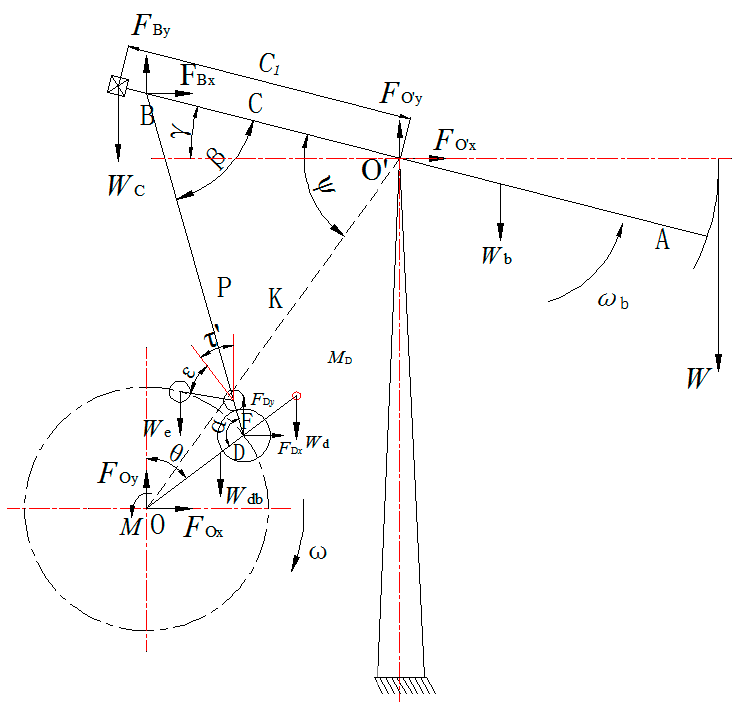
Figure 6. Force analysis diagram of the whole pumping unit.